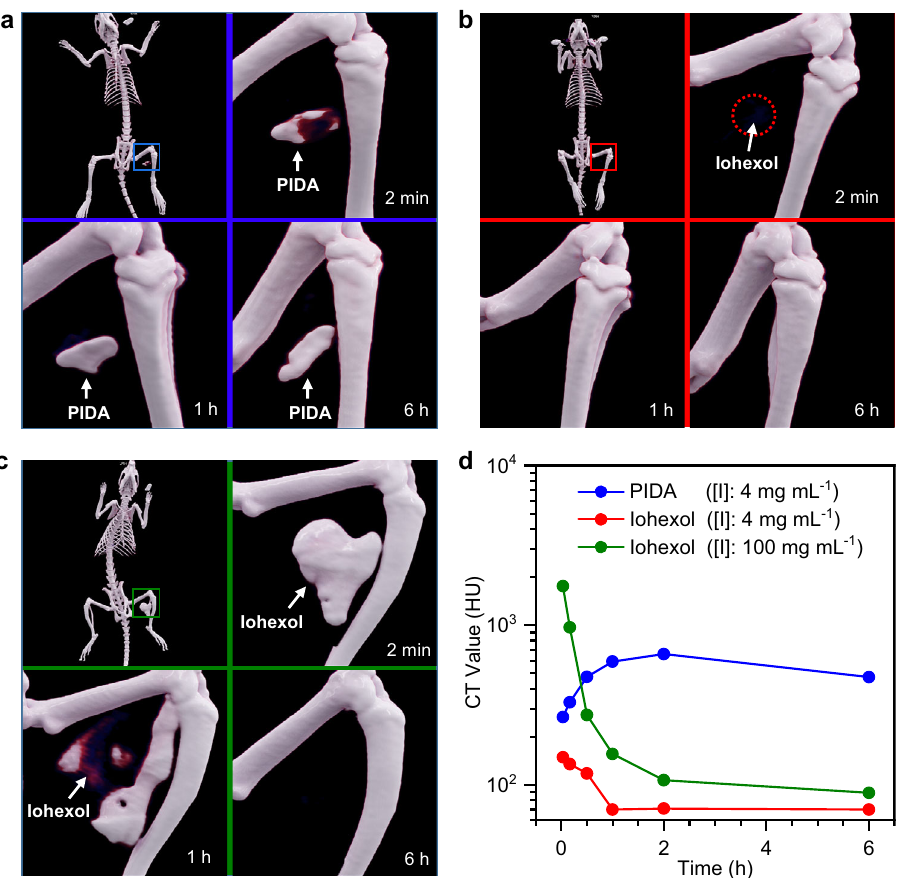
Fig. 2 The performance of PIDA and iohexol in CT imaging of rats. a CT images of a rat at different time after being injected with 200 μ L PIDA suspension ([I]: 4 mg mL − 1 ). b CT images of a rat at different time after being injected with 200 μ L of iohexol ([I]: 4 mg mL − 1 ). c CT images of a rat at different time after being injected with 200 μ L of iohexol ([I]: 100 mg mL − 1 ). d Plots of CT values of different markers in ( a – c ) as a function of time post- injection. Source data are provided as a Source Data fi